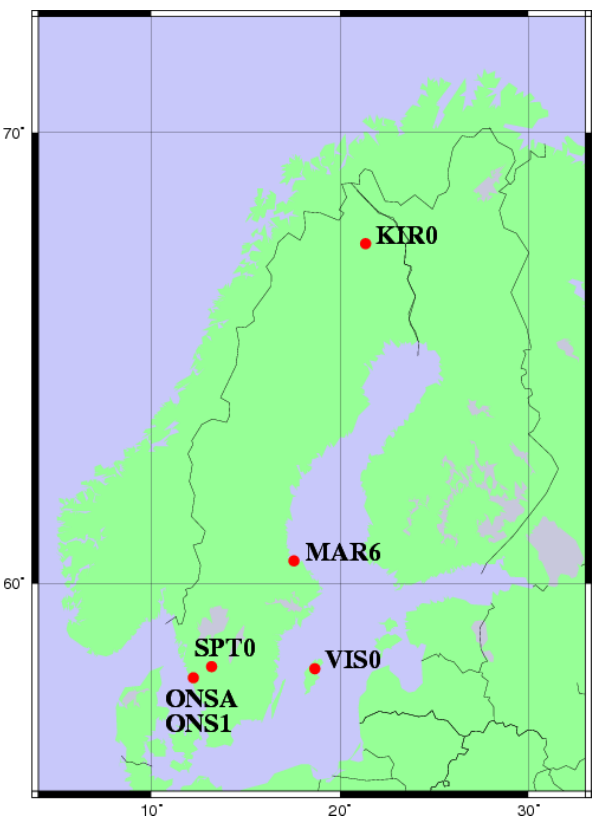
Figure 1. The five sites used in the study. Two antenna installations, ONSA and ONS1, are co-located together with the VLBI telescope and the WVR at the Onsala site. An antenna installation is referred to as a